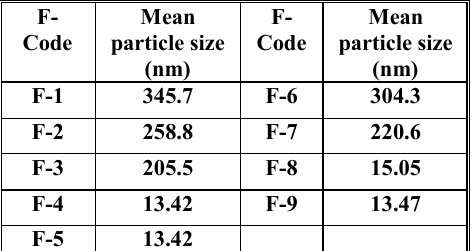
Table 4. Particle size measurement for LCDP